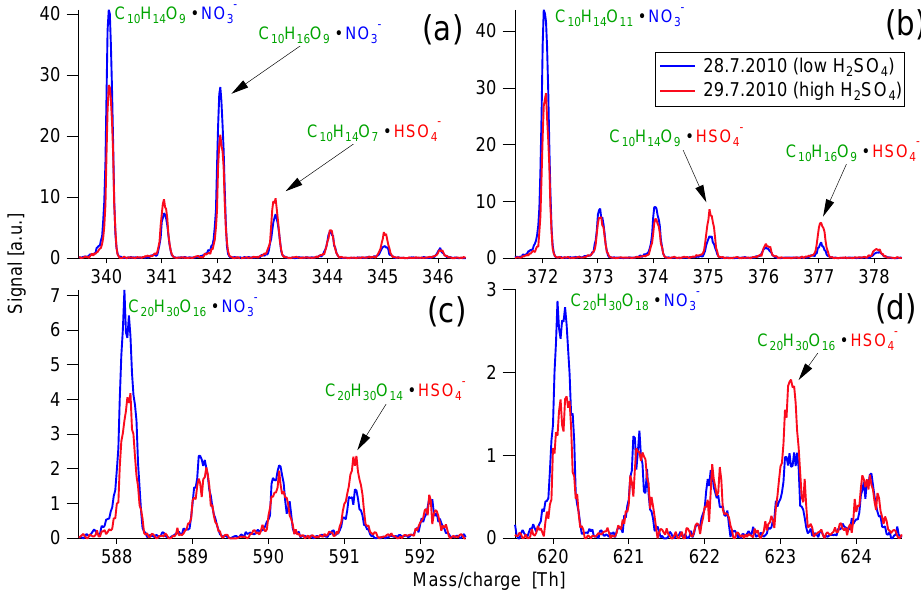
Fig. 5. Comparison of mass spectra during two consecutive nights, where the first was a “normal” night with low SO 2 and H 2 SO 4 , but the second had unusually high levels of both. The four subplots show different parts of the ion spectrum, with the aim to show how HOM · HSO − clusters increase at the expense of HOM · NO − 4 (C 10 H 14 O 9 · NO − ) 3